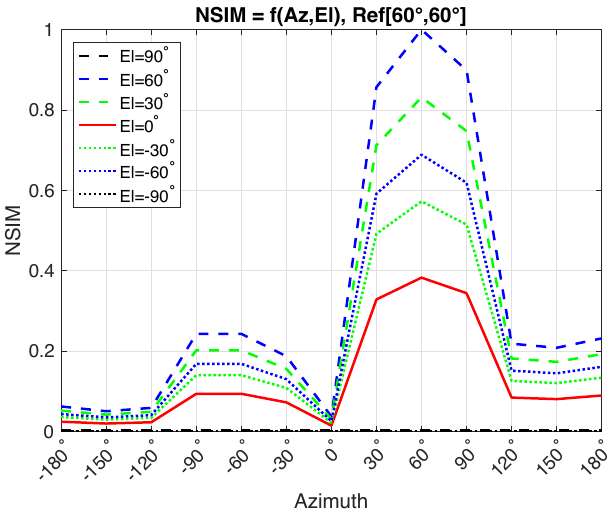
Figure 14. Localization accuracy as a function of azimuth and elevation with fixed reference audio source, localized at an offset point of azimuth = 60 ◦ , elevation = 60 ◦ . The asymmetry in the results is caused by the source being closer to one ear than the other. Reproduced from [4].